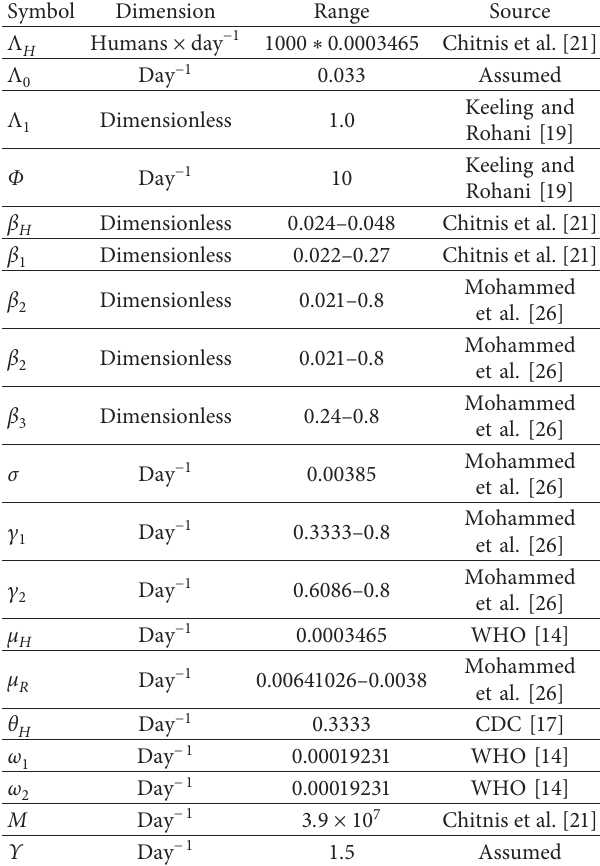
Table 5: Values and ranges for parameters used in the Lassa fever